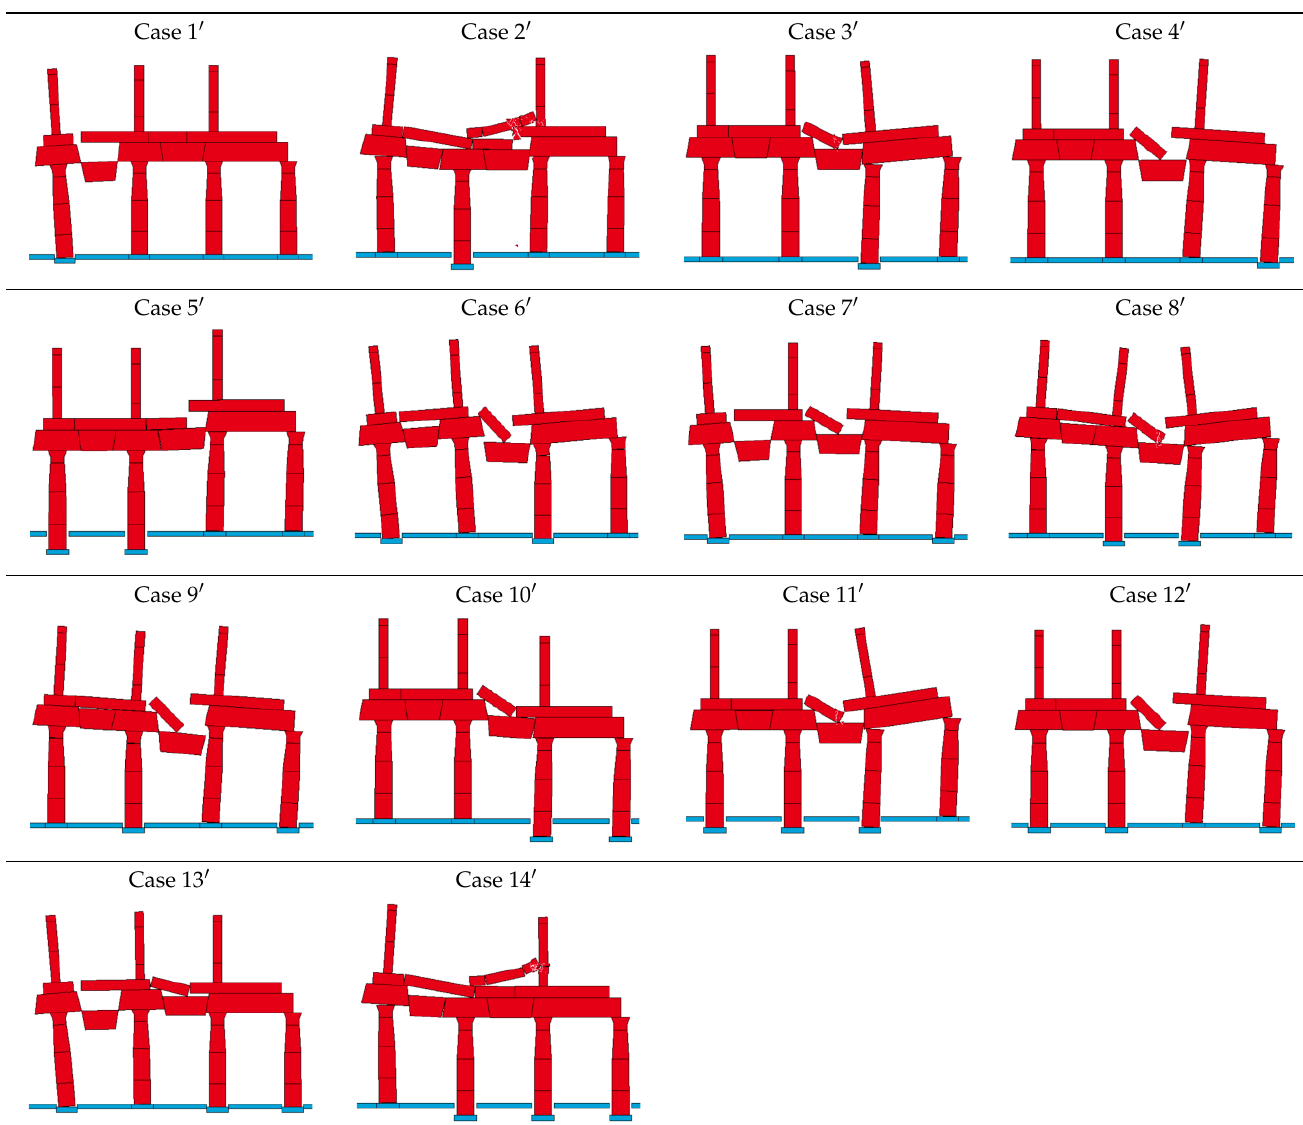
Table 6. Failure of the colonnade due to differential settlement considering fracture.